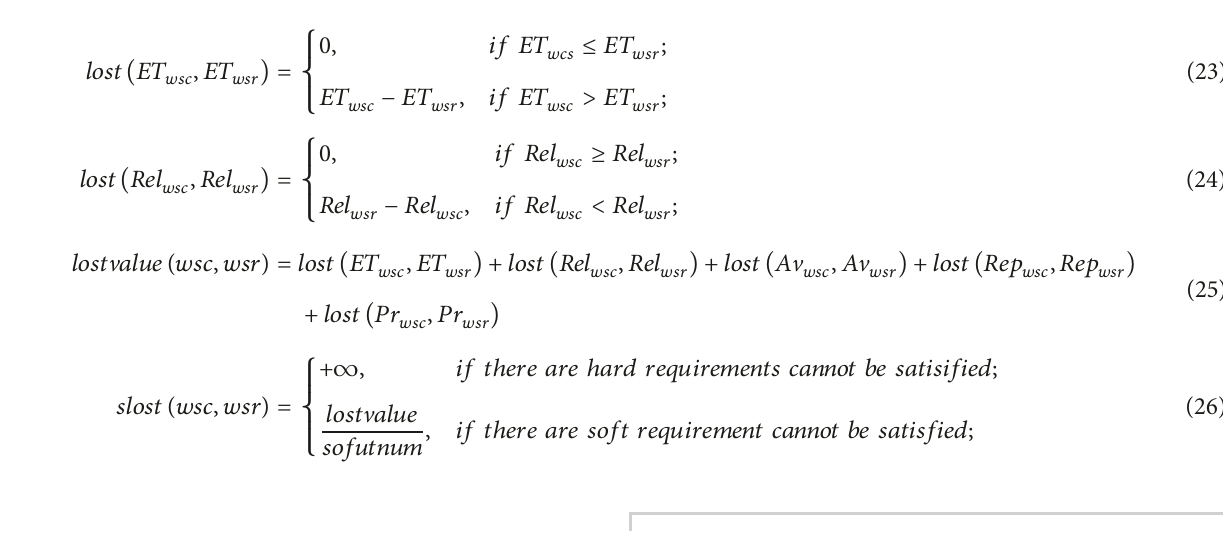
Algorithm 3 is the service selection method for the soft requirement of QoS attributes under the method of